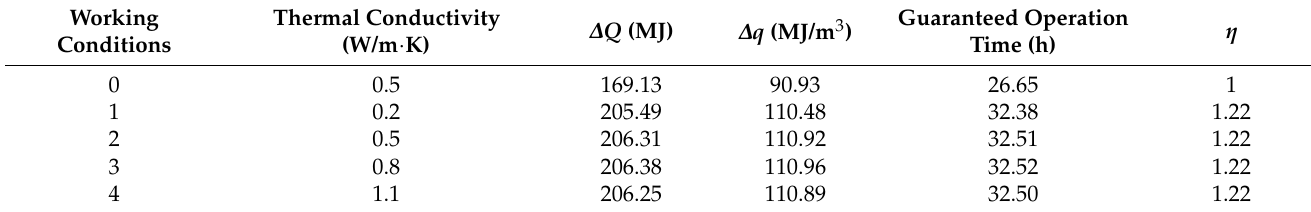
Table 6. Effect of thermal conductivity on the performance of the reservoir.